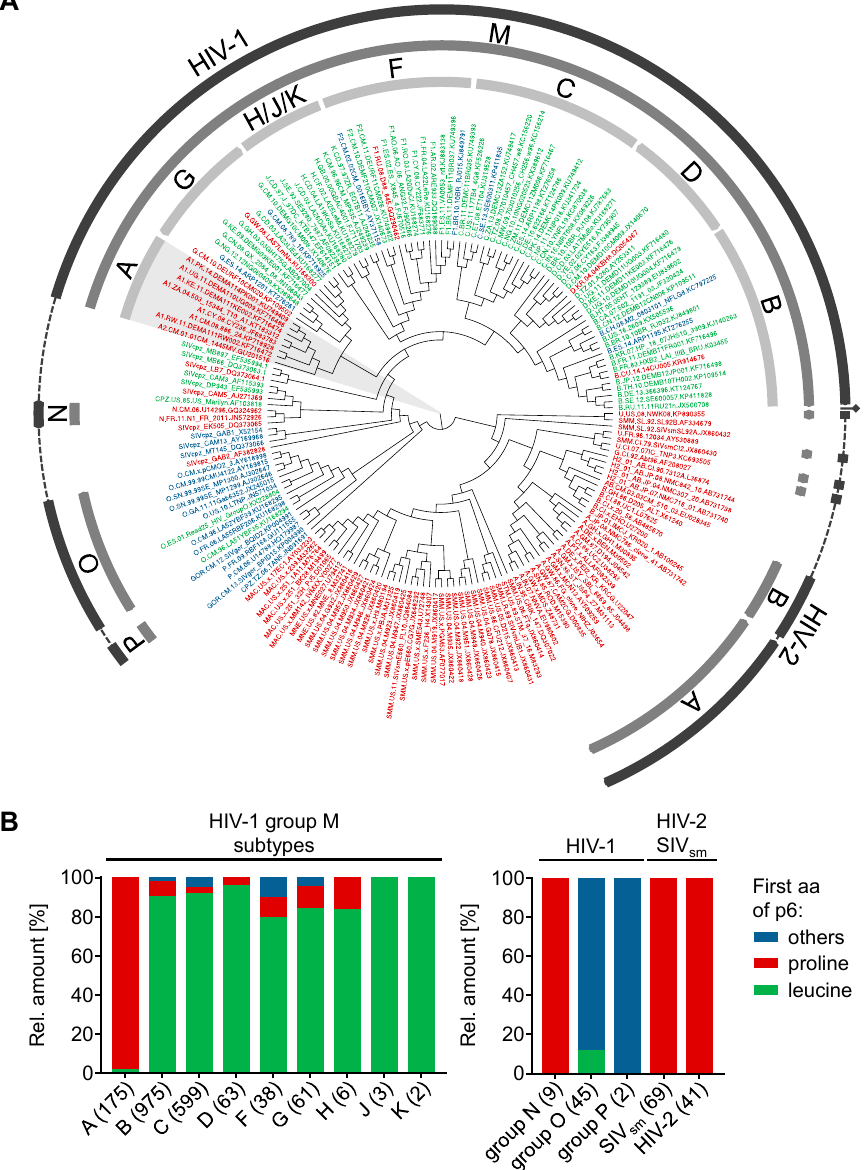
Figure 6. Phylogenetic background of the aa at position one of p6. ( A ) SATé HIV-1/SIV/HIV-2 phylogeny in circular form. In the phylogenetic tree, the isolates have been colored corresponding to the first aa of p6. Isolates with a proline at position one of p6 are depicted in red, isolates in which p6 begins with leucine are colored green, and all other isolates are written in blue. The labeled rings indicate the virus species HIV-1 or HIV-2, respectively (outer), groups (middle) and subtypes (inner). ( B ) A total of 2088 representative sequences from the Los Alamos Sequence Database have been analyzed in silico regarding the first aa of p6. Depicted are the aa occurrences at position one of the p6 peptides of all HIV-1 groups and subtypes, SIVsm (including SIVmac sequences) and HIV-2. Sequences of p6, which begin neither with proline (red) nor with leucine (green), have been summarized as others (blue). The number of analyzed sequences is indicated in brackets and was set to 100% for each